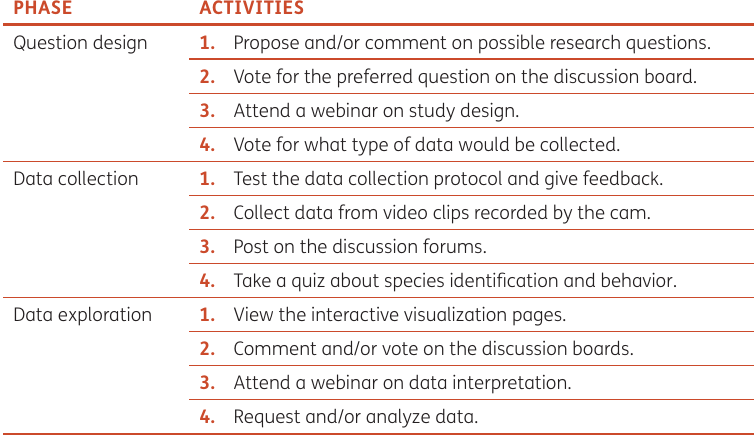
Table 1 For each of the scientific phases included in the analyses, participants were given opportunities to engage with each other and scientists in a variety of ways (See Supplemental File 1: Activities for more details and screenshots of each